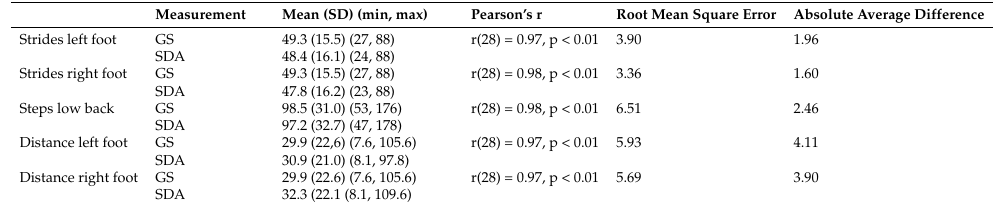
Table A2. Comparison between the outcomes of the golden standard and stride-detection